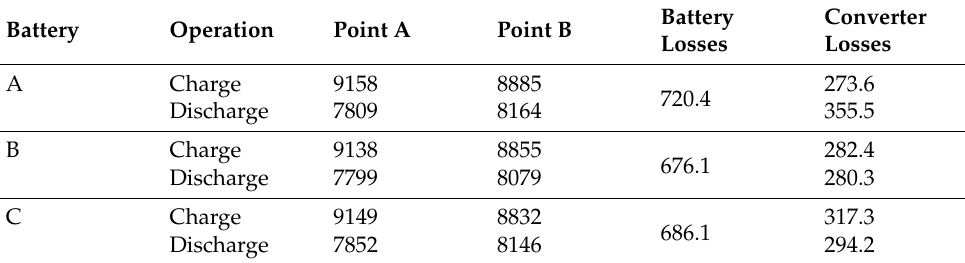
Table 1. Energy measurements for Points A and B, in Wh.